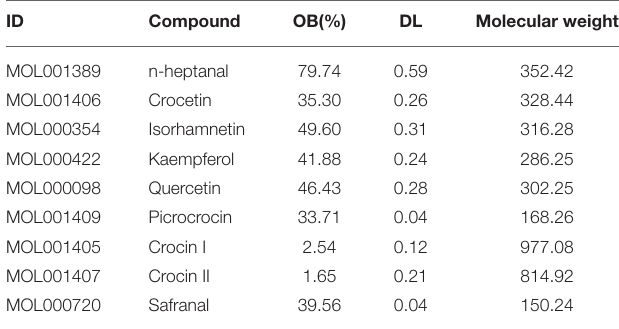
TABLE 1 | The detailed information and parameters of nine bioactive ingredients of